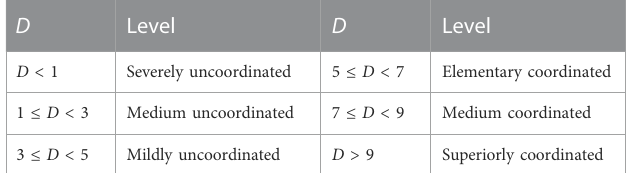
TABLE 2 Standard of coupling coordination degree